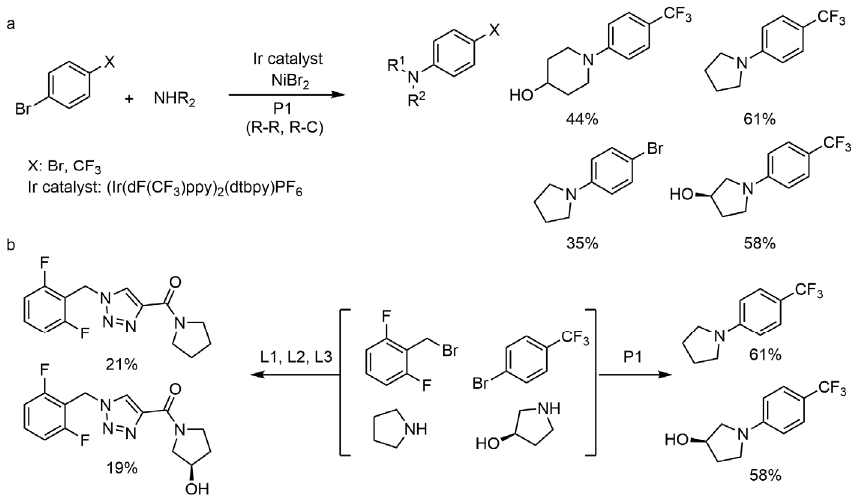
Figure 6. Modular expansion of system functions: ( a , b ). Adapted with permission from ref. [54]. Copyright 2020, Springer Nature.